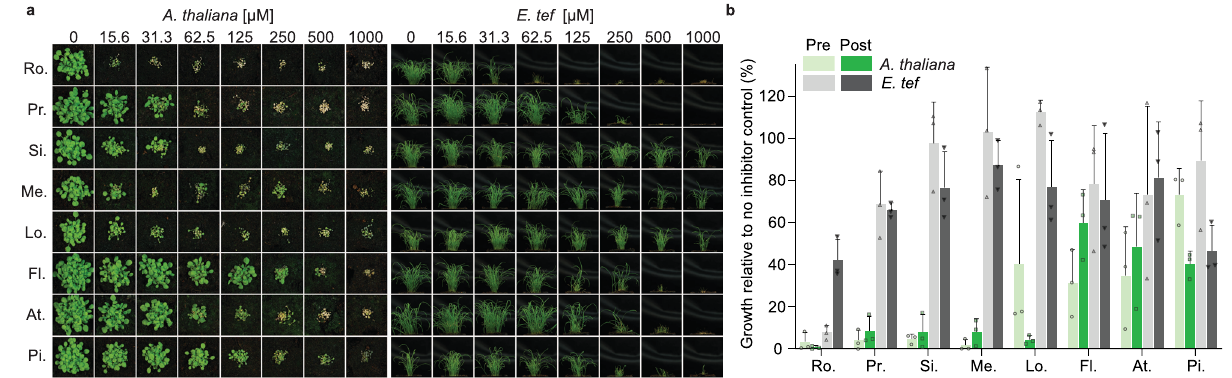
Fig. 1 | Herbicidal activity of statins varies between a model dicot and a monocot.a Representativeimagesfromthepost-emergencetreatmentofamodel dicot, A.thaliana ,andpre-emergencetreatmentofthemonocot E.tef ,withstatins: rosuvastatin (Ro.), pravastatin (Pr.), simvastatin (Si.), mevastatin (Me.), lovastatin (Lo.), fl uvastatin (Fl.), atorvastatin (At.) and pitavastatin (Pi.). b A . thaliana (green)